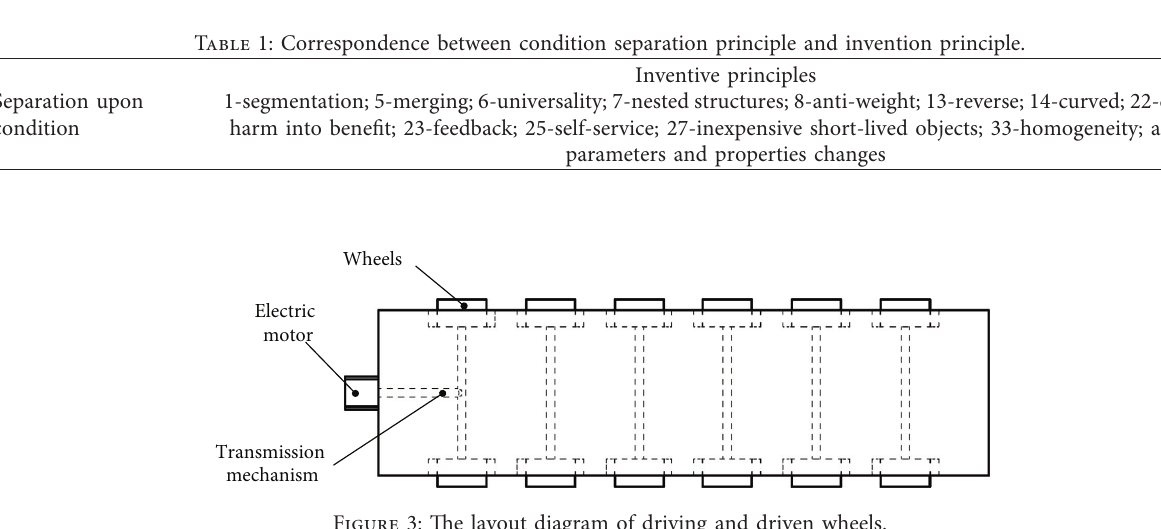
Figure 3: The layout diagram of driving and driven wheels.